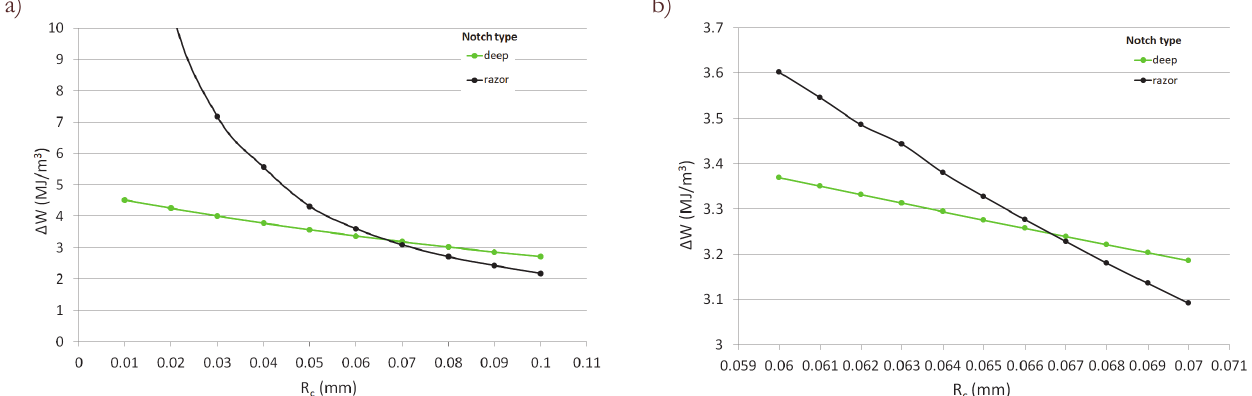
Figure 6: Determination of the SED critical parameters: (a) The value of the critical radius R C has been varied with a step of 0.01 mm and (b) with a finer step of 0.001